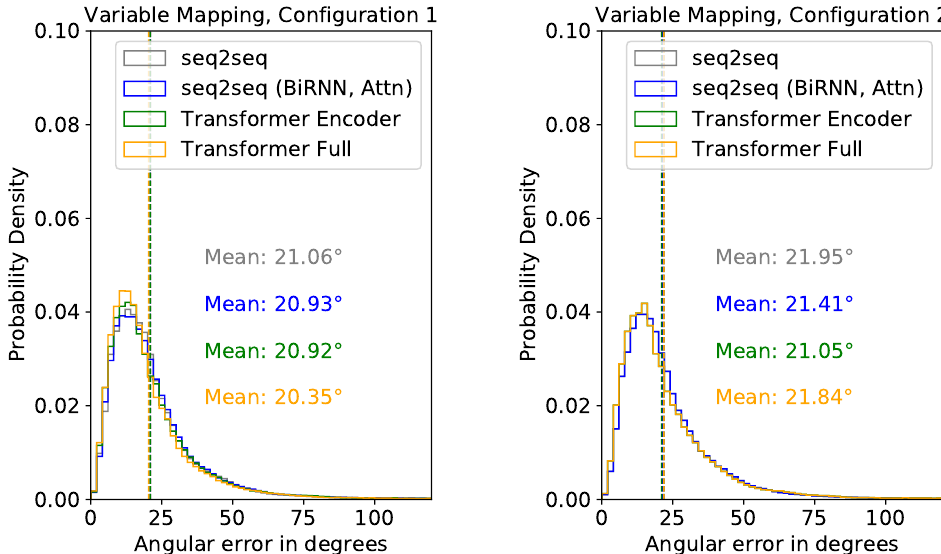
Figure 19. Angular error distribution of motion inference using Xsens DOT sensor with varying configurations (from the new dataset). Configuration 1 had the pelvis sensor on the back of the pelvis, next to the XSens sensor; Configuration 2 had the pelvis sensor on the side of the pelvis. Table 3. Mean angular error of different models with varying configurations for inference using DOT sensors with the fixed mapping function (with the new test set). Deep Learning Model Fixed Mapping, Configuration 1 Fixed Mapping, Configuration